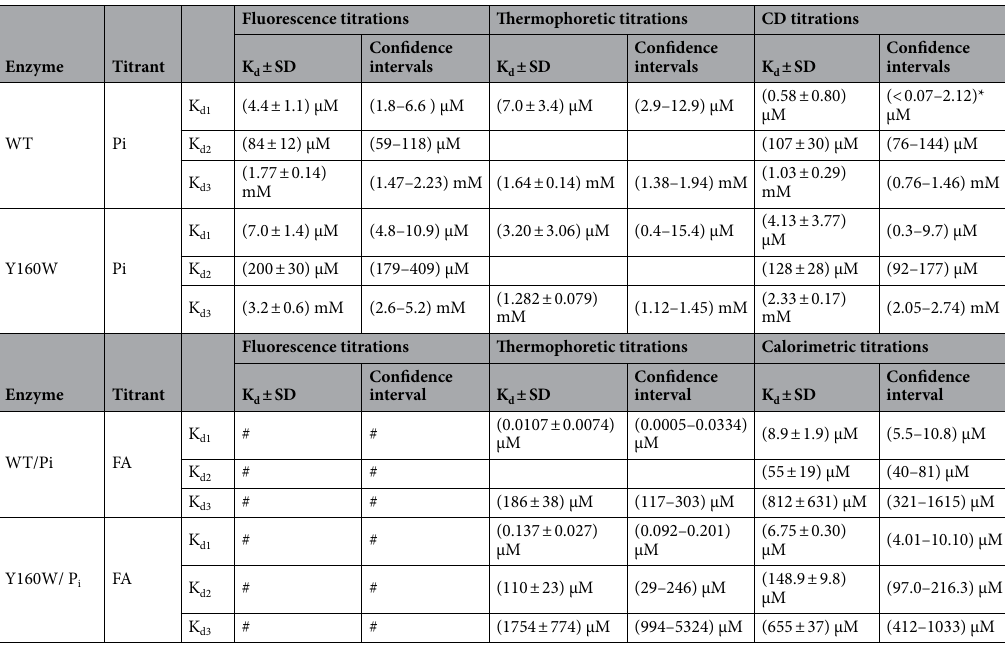
Table 3. Dissociation constants of the WT PNP and the Y160W mutant complexes with phosphate (Pi), and the WT PNP/Pi and the Y160W mutant/Pi complexes with formycin A (FA), determined by various experimental methods. Experiments were conducted at 25 °C, in 50 mM Tris/HCl buffer at pH 7.6, and in the case of titrations with formycin A in the presence of 50 mM phosphate buffer pH 7.6. Dissociation constants obtained from the global fitting (see “Methods” section) with standard deviations are shown, and also the confidence intervals at 3σ level (in parenthesis) . *In this case the confidence interval is not closed from the bottom, as the lower bound is lower than the lowest ligand concentration used in titrations (0.007 μM). # The strong absorption of FA makes fluorimetric titrations impossible even at moderate ligand concentrations.